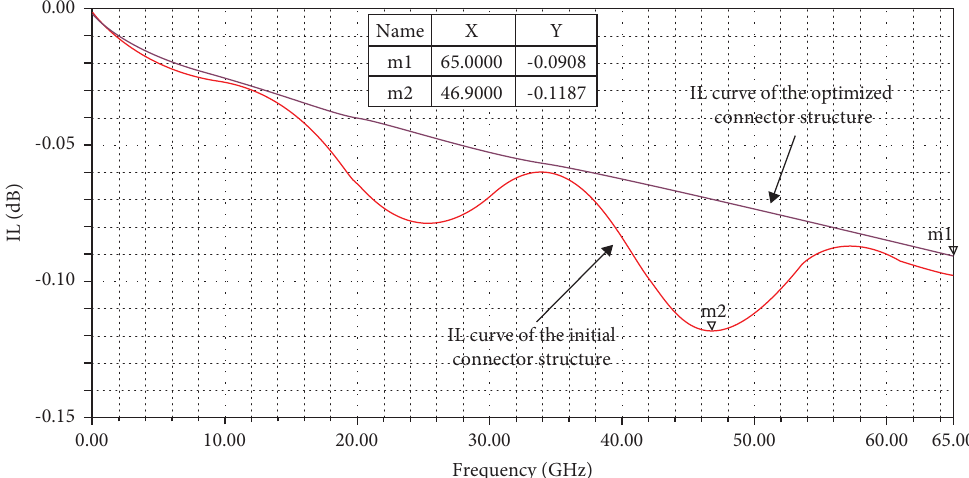
Figure 7: Comparison of the connector’s IL curves before and after optimization.